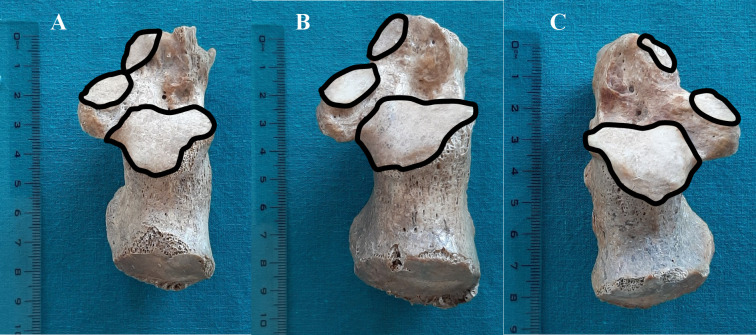
Pattern 2 of calcaneal facets for the talus: (A) pattern 2a, (B) pattern 2b, (C) pattern 2c.